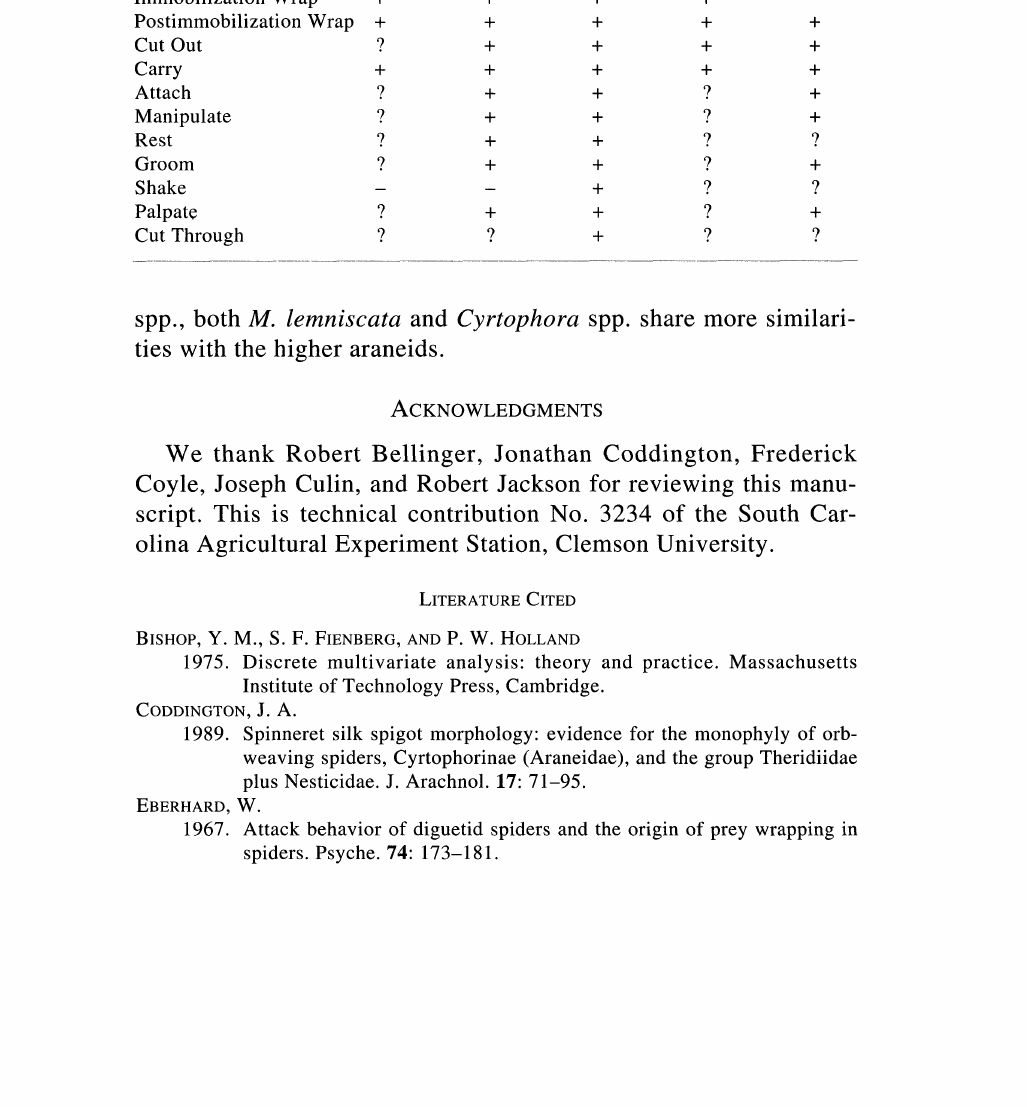
Table 2. Presence (+), absence (-), or uncertainty (?) of major predatory behav- ioral acts of Mecynogea lemniscata observed in other Araneidae and Tetra- gnathidae. See text for